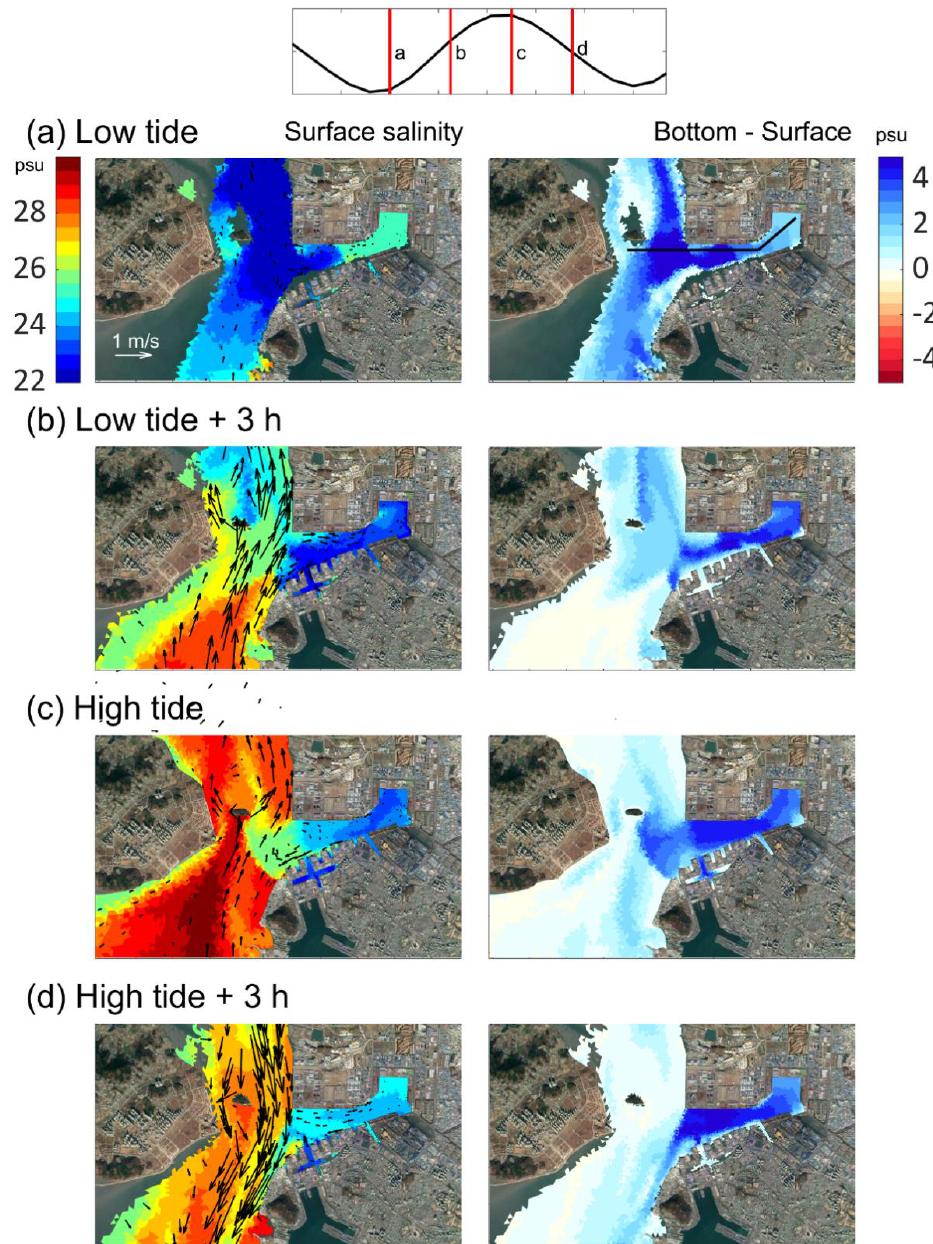
Figure 7. Spatial distributions of depth-averaged velocity and surface salinity ( left ) and vertical salinity difference ( right ) from the model results in summer under high river discharge conditions. Positive value (blue shades) in the salinity difference means that surface seawater is fresher than bottom water.